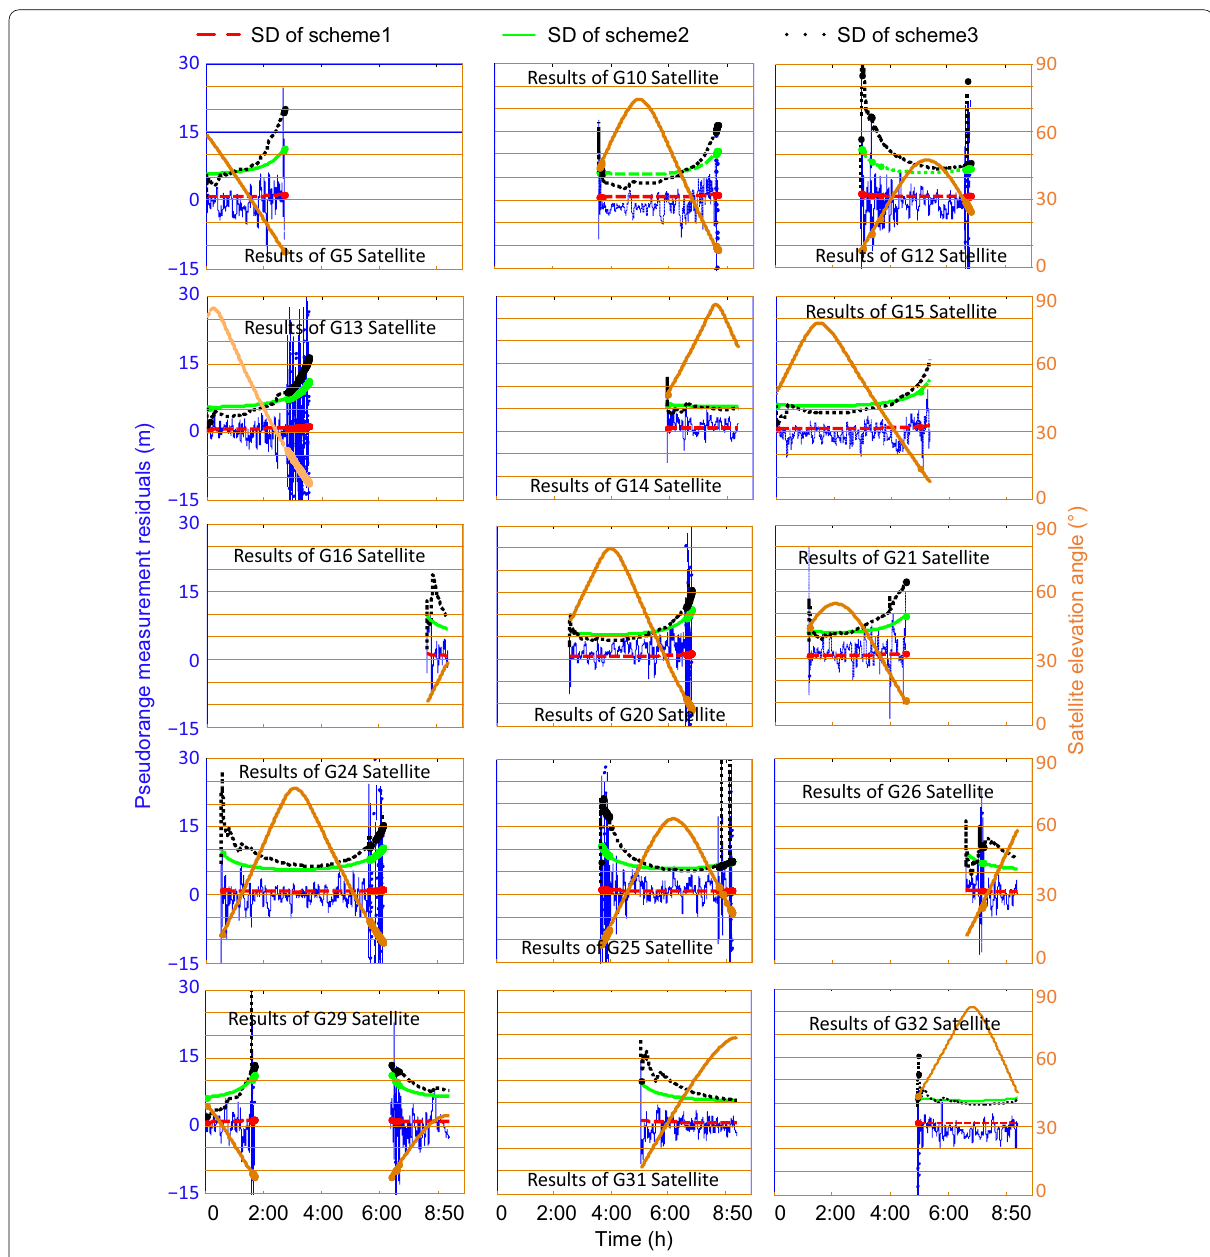
Fig. 6 Pseudorange measurement residuals and standard deviation estimates for each